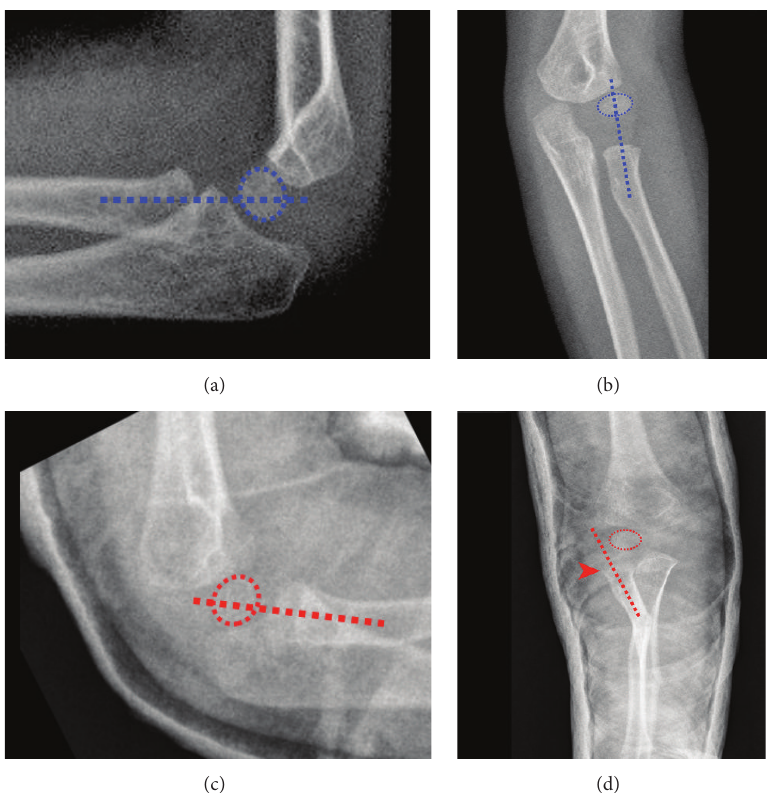
Figure 2: AP (a) and lateral (b) views of the healthy side with radiocapitellar lines. AP (c) and lateral (d) views of the injured side with radiocapitellar lines after closed reduction. Arrow head shows laterally dislocated radial